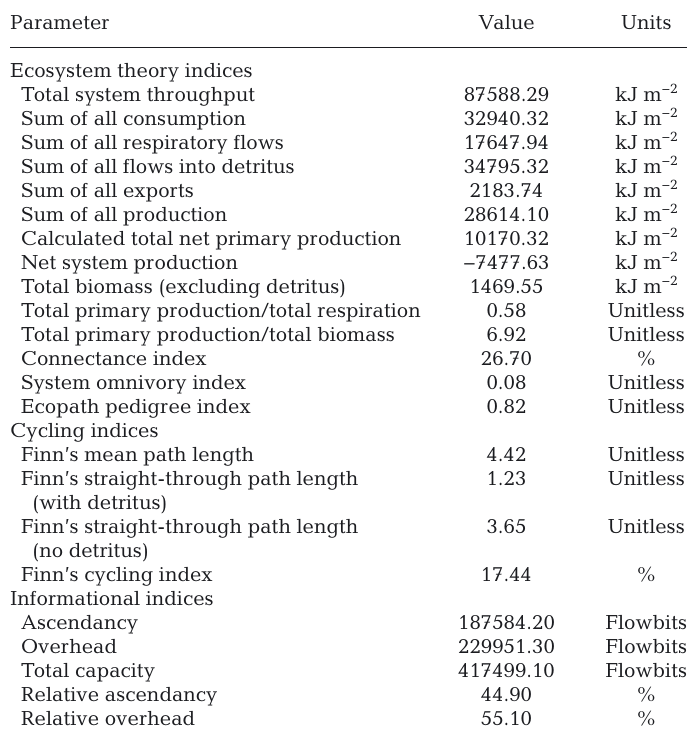
Table 4. Ecosystem indicators describing the 4-species polyculture eco - system structure. Units were calculated over the 90 d experimental